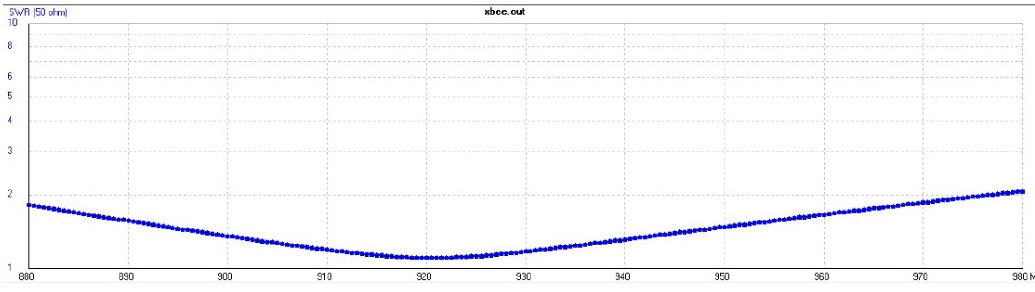
Figure 16. Simulation results of the operating frequency range of XBee